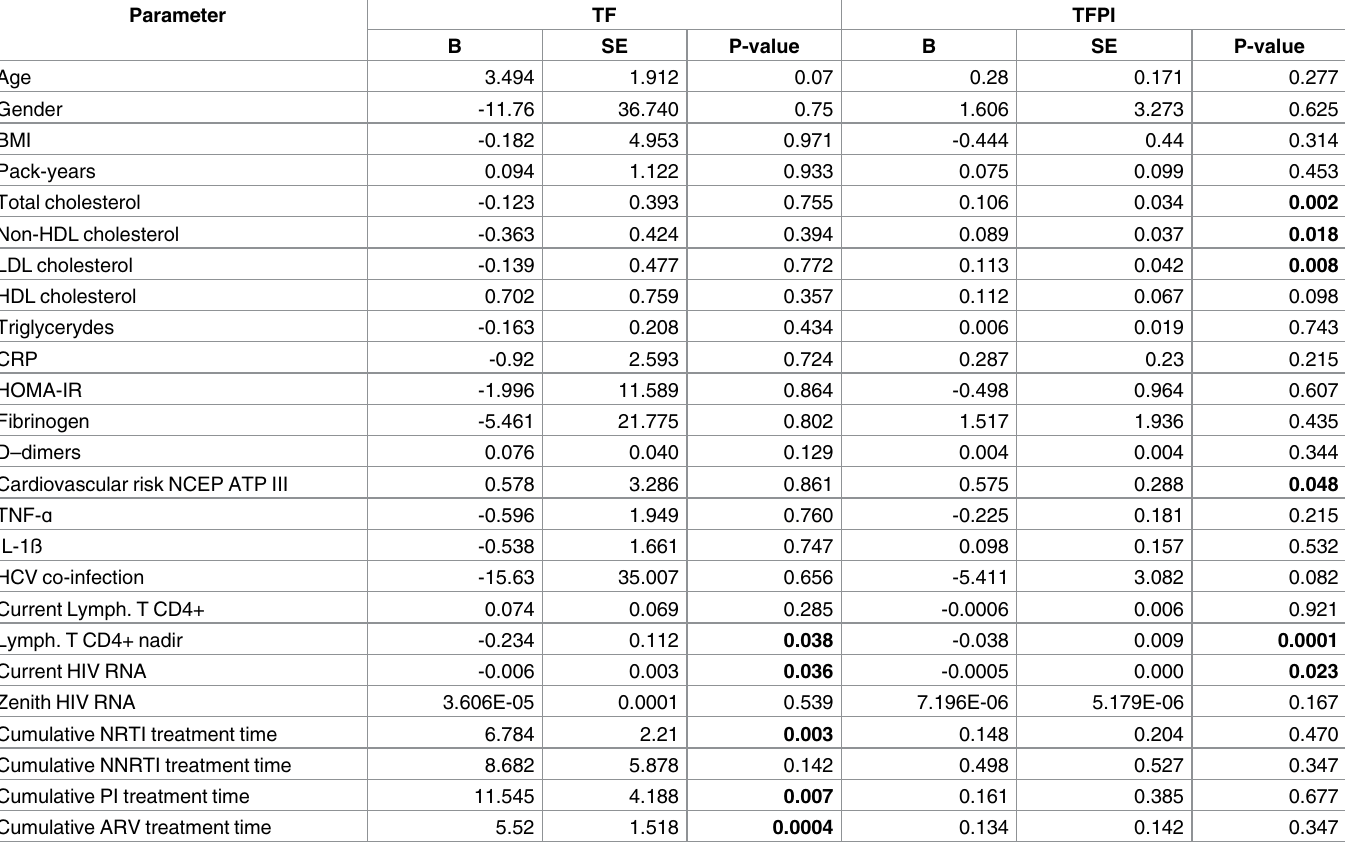
Table 3. Effect of cardiovasculardisease risk factors on the concentration of TF and TFPI (univariate linear regression).